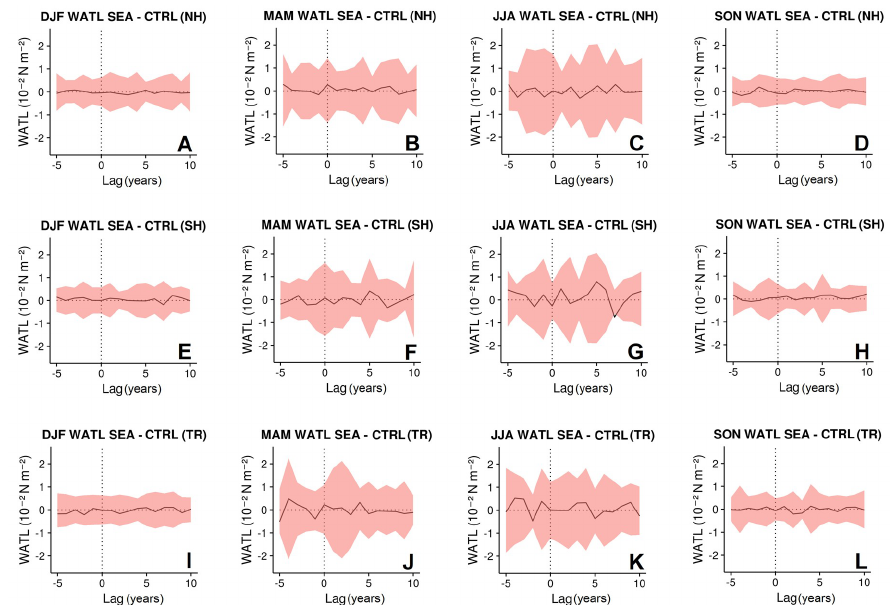
Figure 5 CTRL SEA for WATL wind stress seasonal anomalies (10 −2 Nm −2 ), calculated after list of volcanic eruptions in Table 1, for five years before the eruption and ten years after the eruption. Horizontal: class of the eruptions (NH – A, B, C and D ; SH – E, F, G, and H ; and TR – I, J, K, and L ); Vertical: seasonal SEA (December to February – DJF; March to May – MAM; June to August – JJA; and September to November – SON). Dark red line corresponds to the CTRL run, and light shaded red corresponds to one standard deviation of the CTRL run.